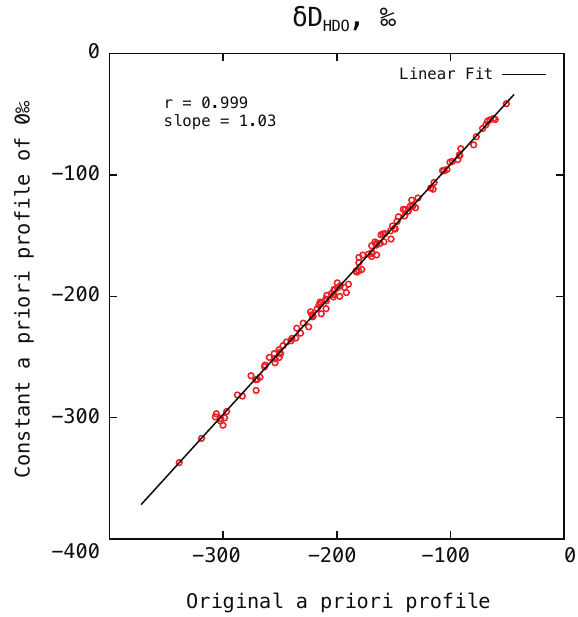
Figure 5. Sensitivity of the retrieval from FTIR observations to dif- ferent a priori assumptions. Retrievals started from initial guess de- fined by Eq. (1) are plotted vs. retrievals started from constant and equal to zero initial guess δ D v vertical profile. Standard deviation of retrieval difference is about